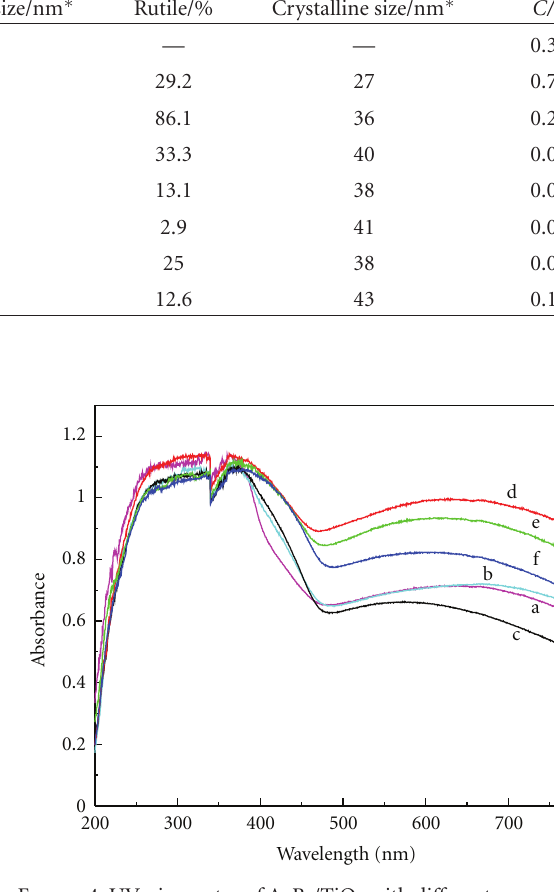
Table 1: Synthesis condition, phase composition, and crystalline size of AgBr/TiO 2 photocatalysts. Sample No.